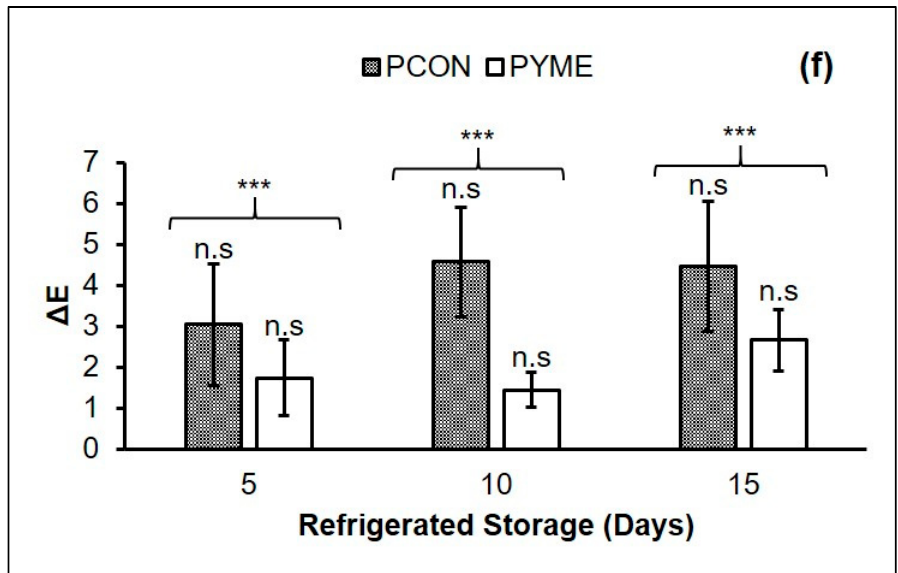
Figure 1. Effect of refrigerated storage (15 days at 4 ± 1 °C) on the color parameters of chicken patties without (PCON) and with the addition of yellow mombin extract (PYME). Results were expressed as mean ± standard deviation. L* ( a ), a* ( b ), b* ( c ), hue* ( d ) ratio a*/b* ( e ), and total colorimetric difference— ∆ E ( f ). Footnotes: Different letters in the upper part of the bars (a–d means within the PCON samples and x–z means within the PYME samples) differ significantly ( p < 0.05) between the days of refrigerated storage. The asterisks show significant differences between the samples on each day of refrigerated storage, n.s.: non-significant, **: p < 0.01 and ***: p < 0.001.